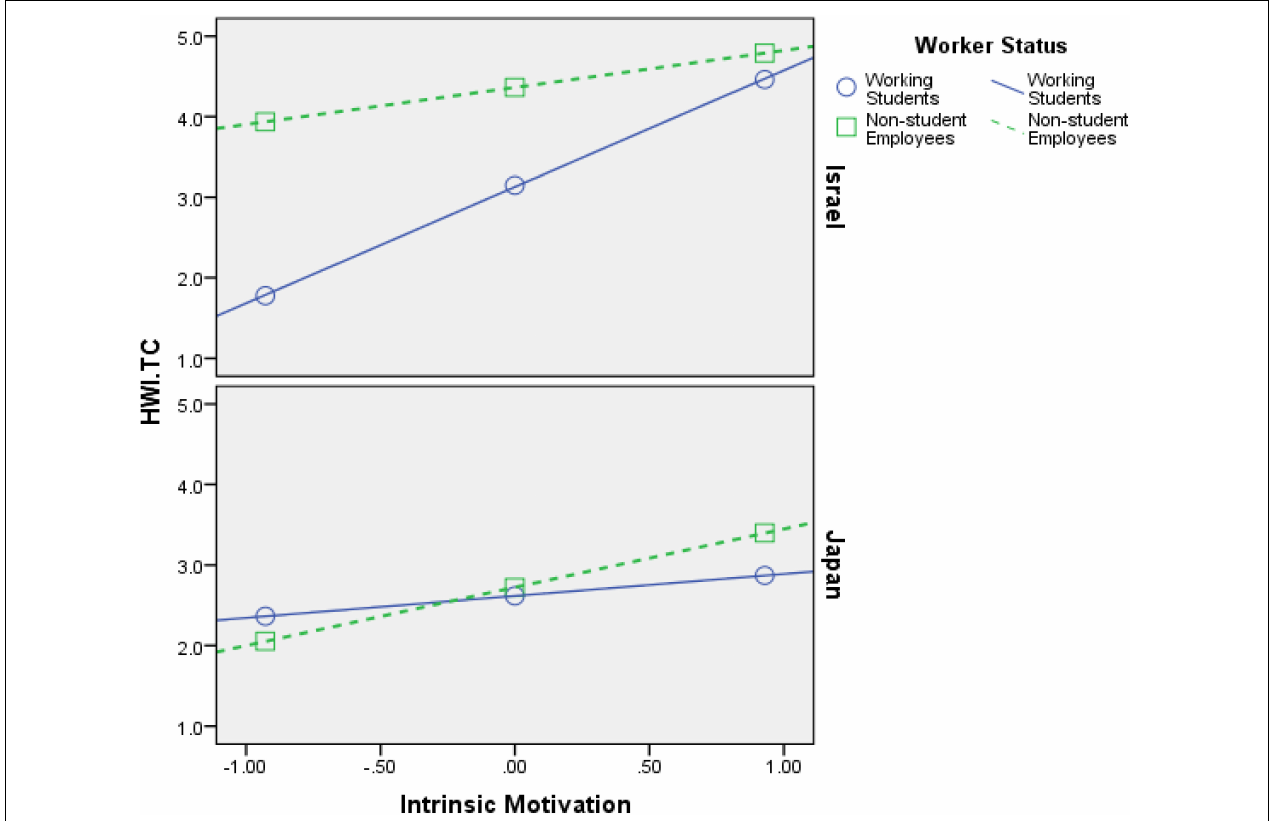
FIGURE 2 | Interaction effects of Intrinsic Motivation × Worker’s Status × Country in predicting HWI-TC. HWI-TC, time commitment dimension of heavy work investment.